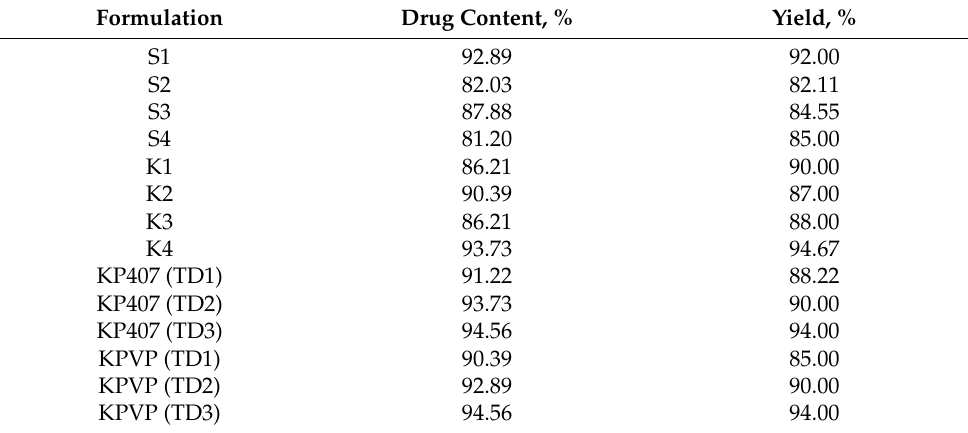
Table 4. Drug content and % yield data of binary and ternary solid dispersion formulations.